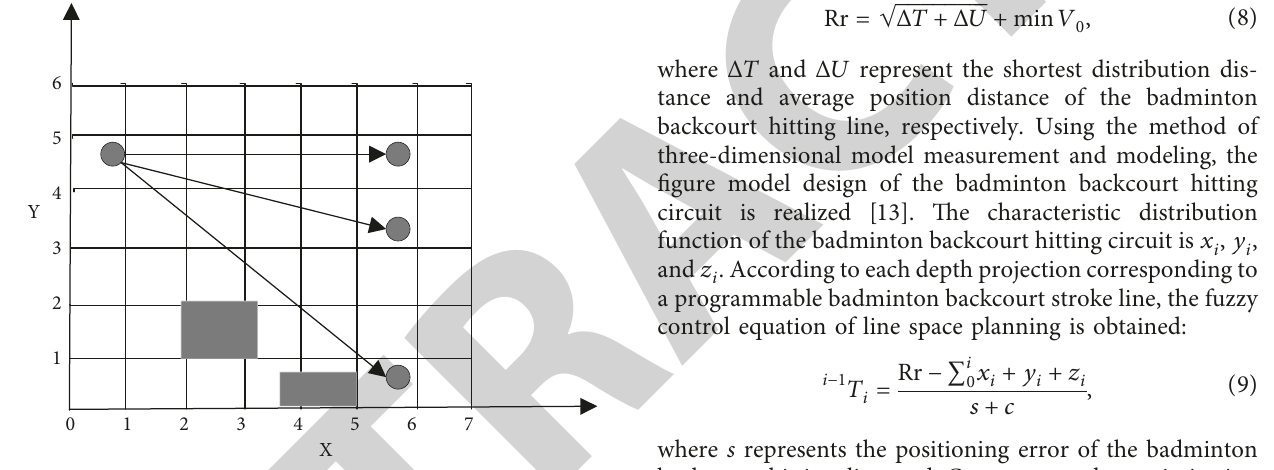
Figure 2: The shortest line distribution grid structure model of the badminton backcourt